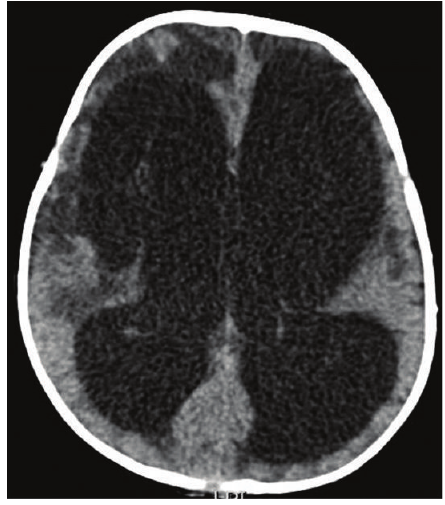
Figure 2: Enhanced brain computed tomography scan nine days after admission. Axial image through the basal ganglia shows hypodensities involving the right head of the caudate and anterior aspect of the putamen (thick white arrow) as well as the right hypothalamus (thin white arrow) representing subacute infarcts. In addition, there is development of bilateral hemispheric hygromas.